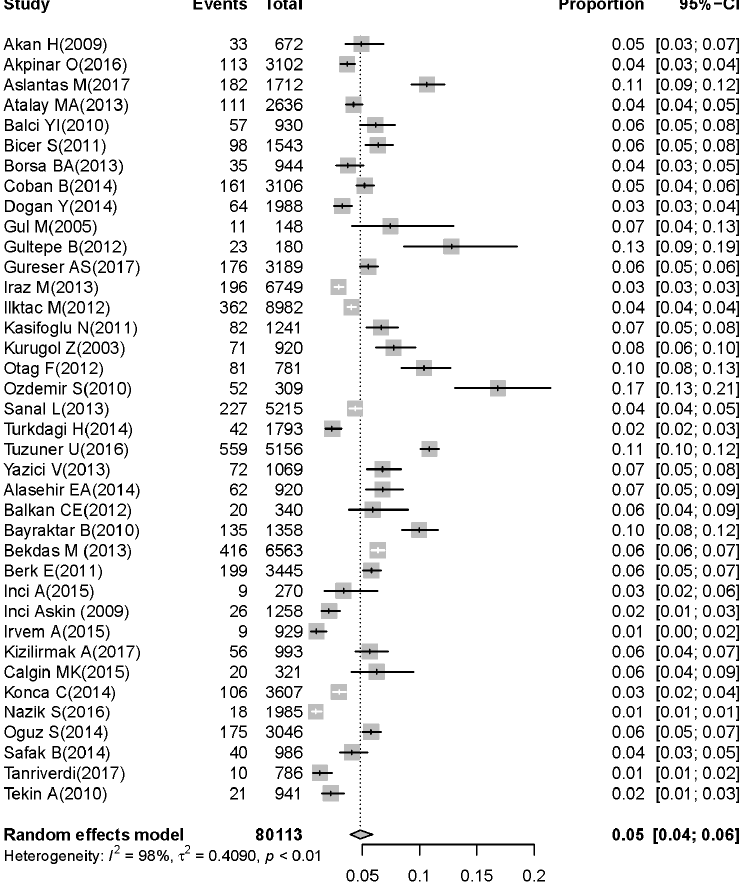
Figure 4. Prevalence of rotavirus-associated acute gastroenteritis cases in children aged 2–5 years.